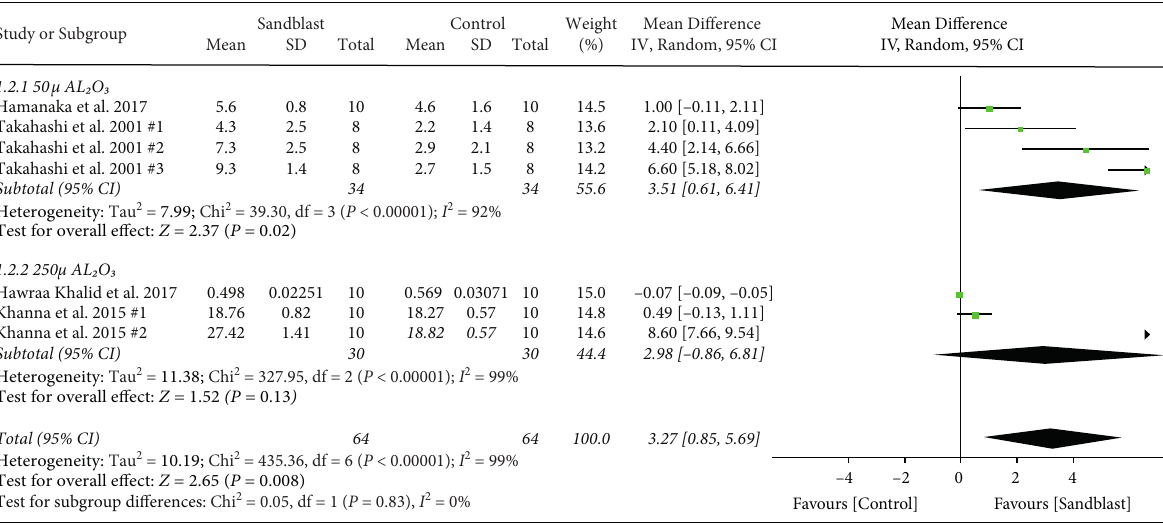
Figure 6: Forest plot for subgroup analysis of particle size for shear bond